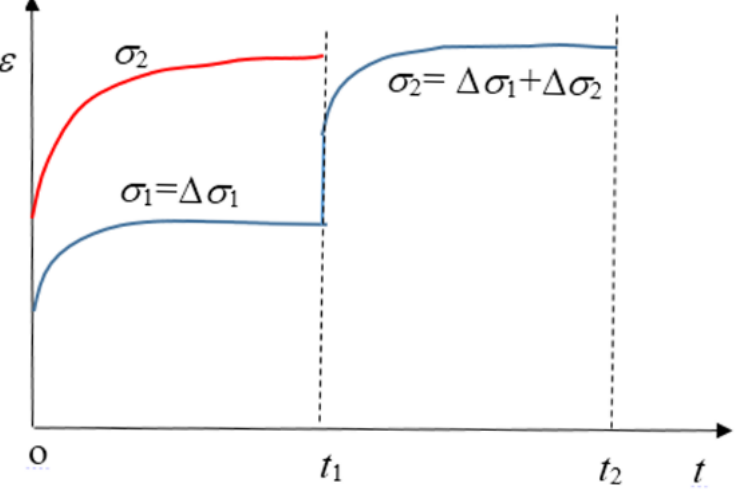
Figure 7. Illustration of creep strain expression considering time effect for the H-K model.